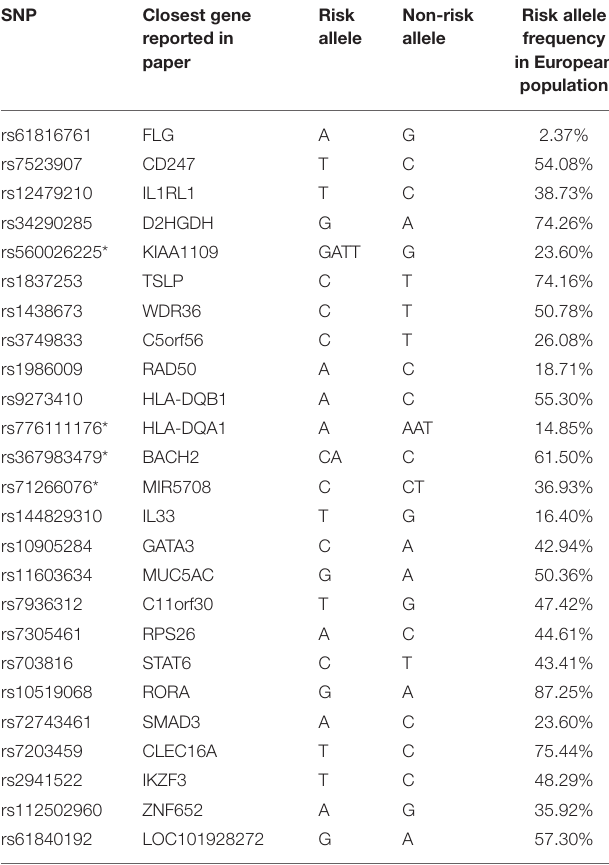
TABLE 1 | The 25 signals from the moderate to severe asthma GWAS. SNP Closest gene reported